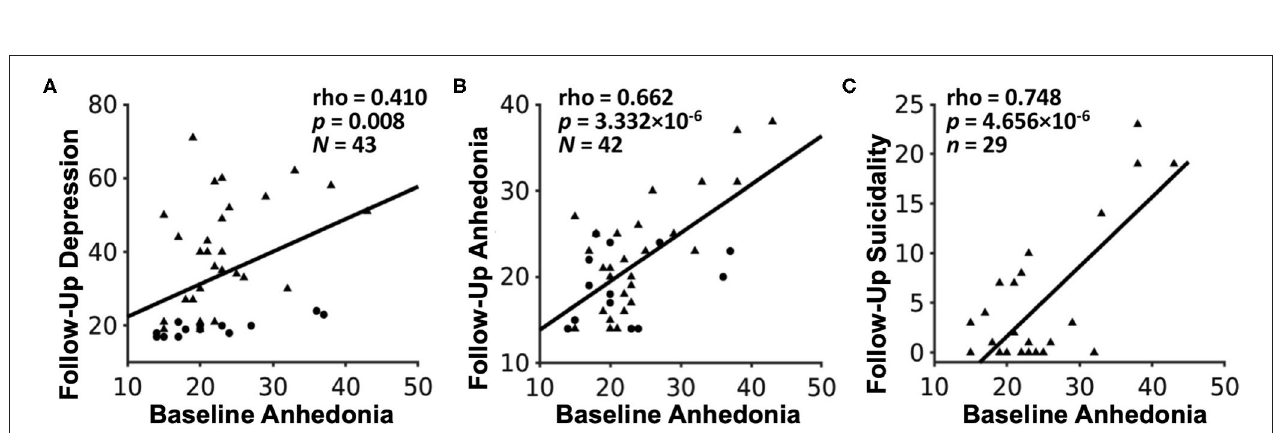
FIGURE 3 | Associations between baseline anhedonia severity and future (A) depression severity, (B) anhedonia severity, and (C) suicidality, assessed after ∼ 24 months in a sample of 29 adolescents with mood and anxiety symptoms (triangles) and 14 healthy adolescent controls (circles). Plots show Pearson partial correlations controlled for baseline age and sex. Adapted from